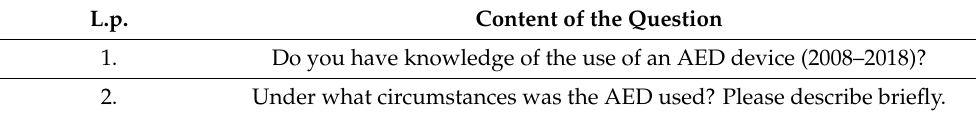
Table 2. Questions from a questionnaire addressed to manufacturers and distributors of AEDs in